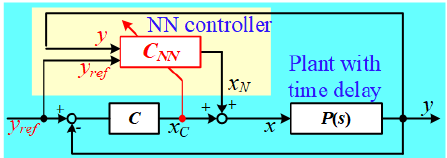
Figure 4. Structure of conventional error feed back ANN control